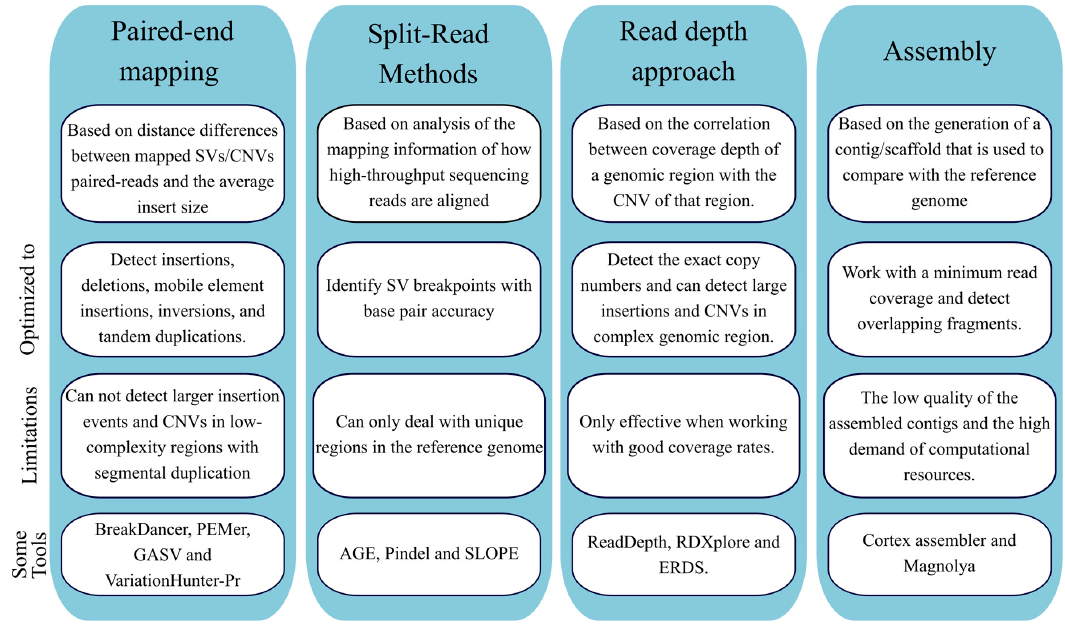
Figure 6. Summary of the main methods for calling structural variants (SV) and copy number variation (CNV) from next generation sequencing (NGS) data.